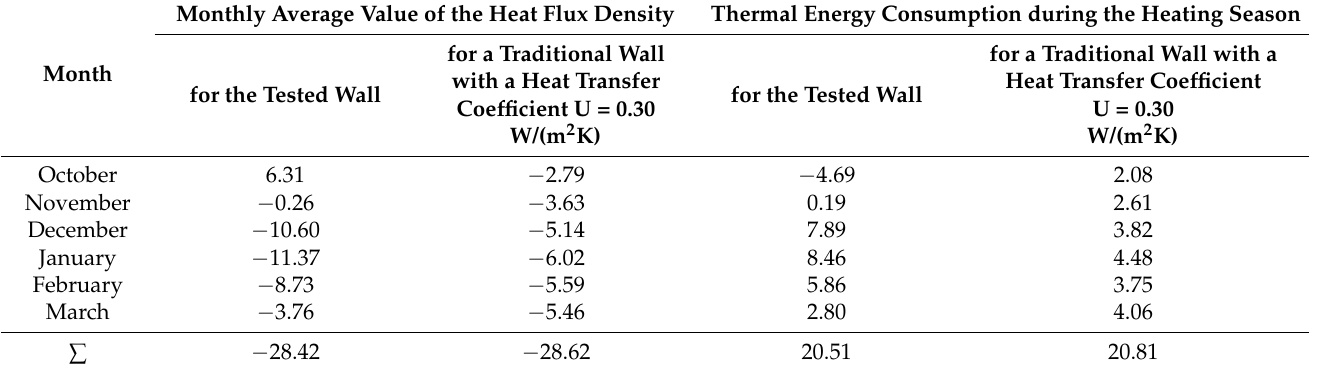
Table 7. Comparison of heat flux for the tested wall and for a wall designed in the traditional system with the coefficient U = 0.30 W/(m 2